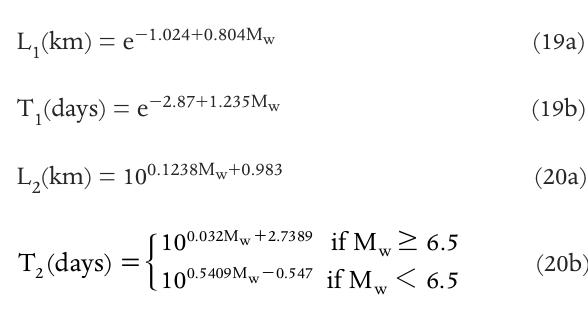
and L are time and 1 1 and L are time 2 2